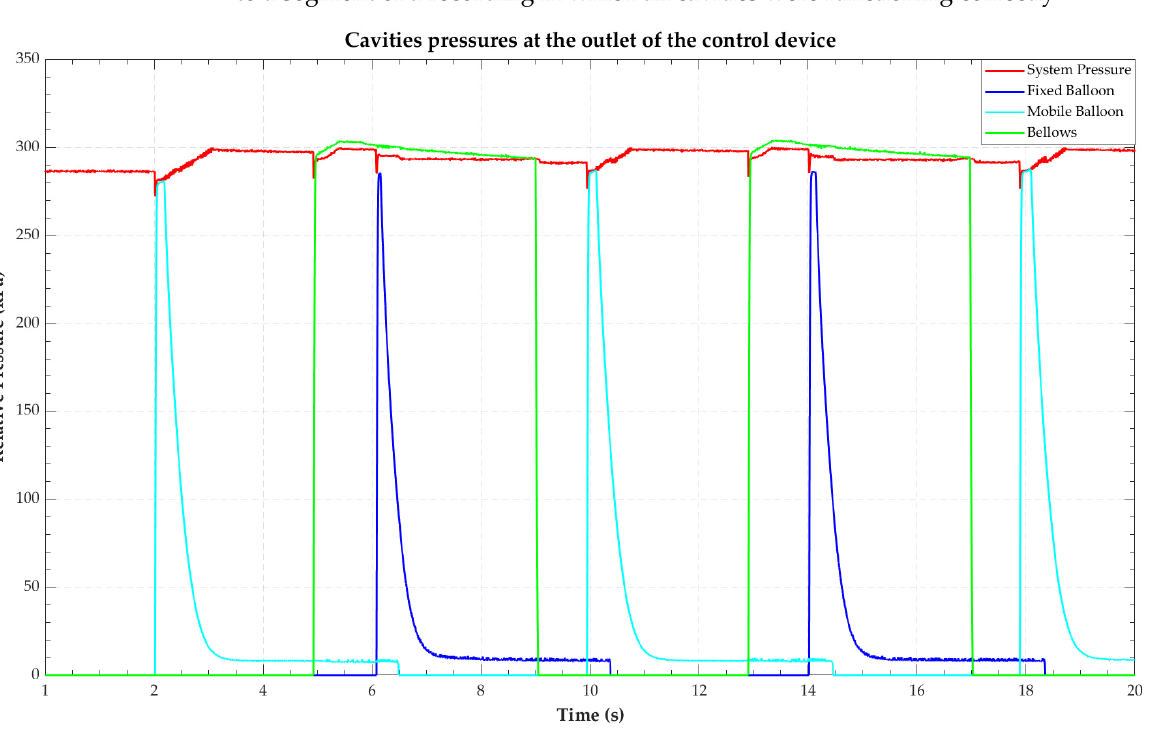
Figure 2. Temporal representation of the four pressures recorded by the Sniffer for any given test: system pressure (red), fixed balloon (dark blue), mobile balloon (blue), and bellows (green).